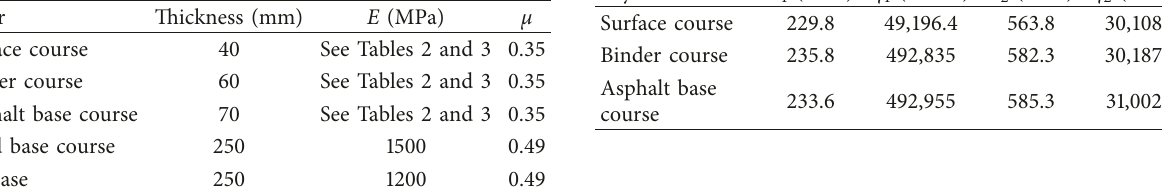
Table 1: Geometry and identical material properties of the pavement in both programs.